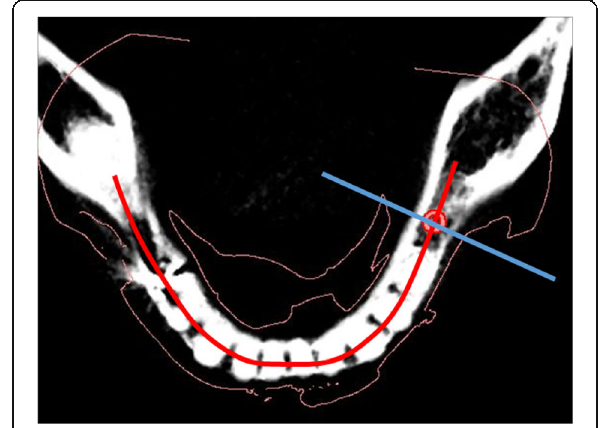
Fig. 4 Bucco-lingual section plane (red line) and mesio-distal section plane (blue